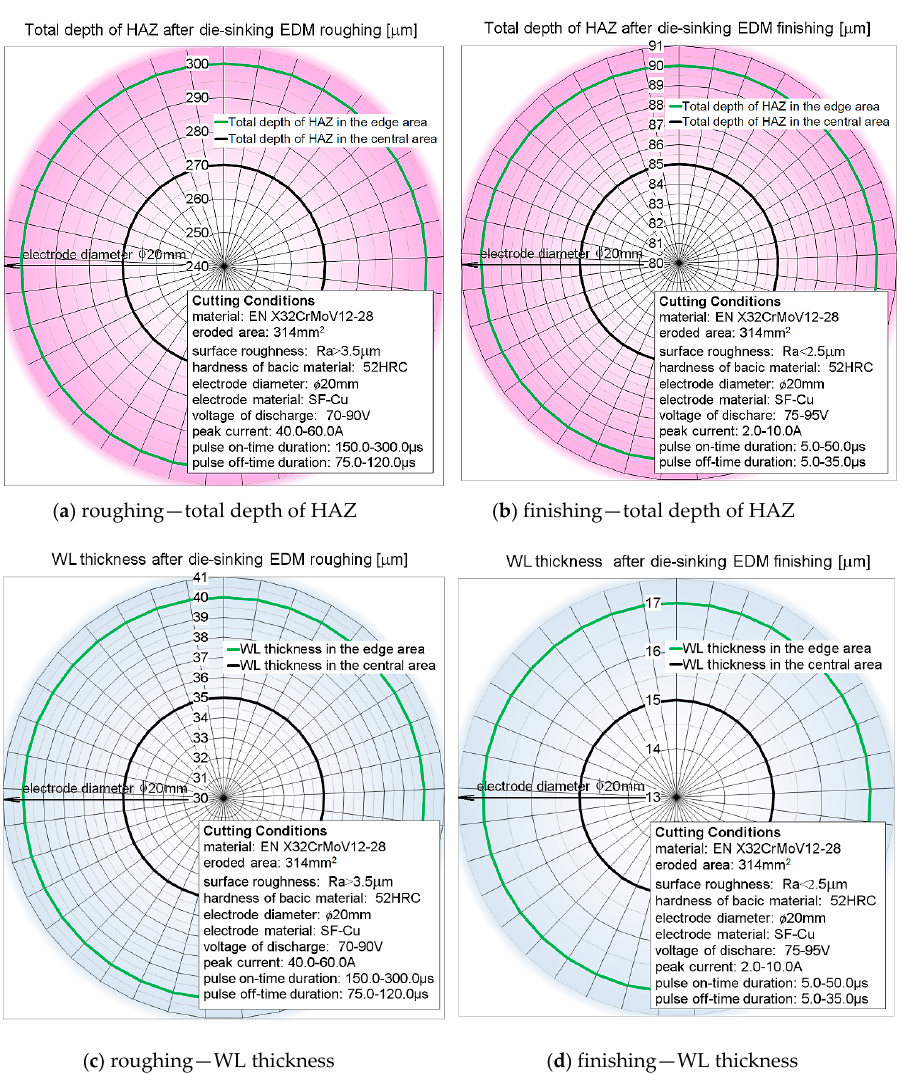
Figure 11. Recorded differences of total thickness of WL and HAZ of a machined surface of 20 mm diameter from tool steel EN X32CrMoV12 ‐ 28 after die ‐ sinking EDM roughing and finishing with a SF ‐ Cu electrode.